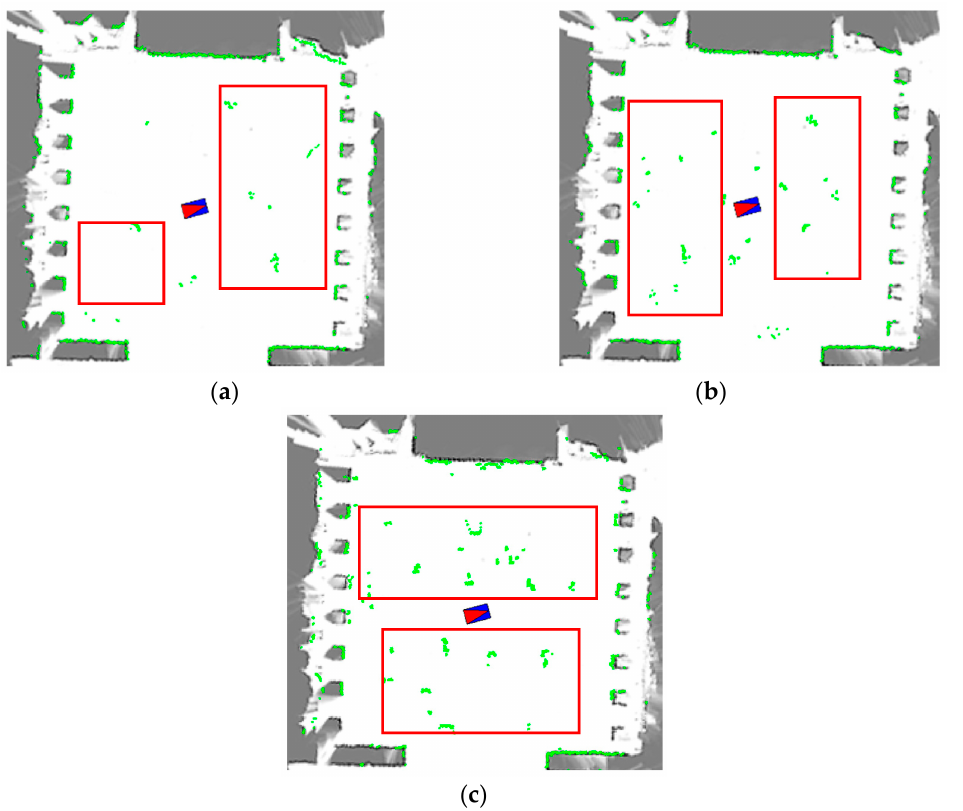
Figure 3. LiDAR measurement in different dynamic scenes at site 2. ( a ) Low dynamic environment. ( b ) Medium dynamic environment. ( c ) High dynamic environment.